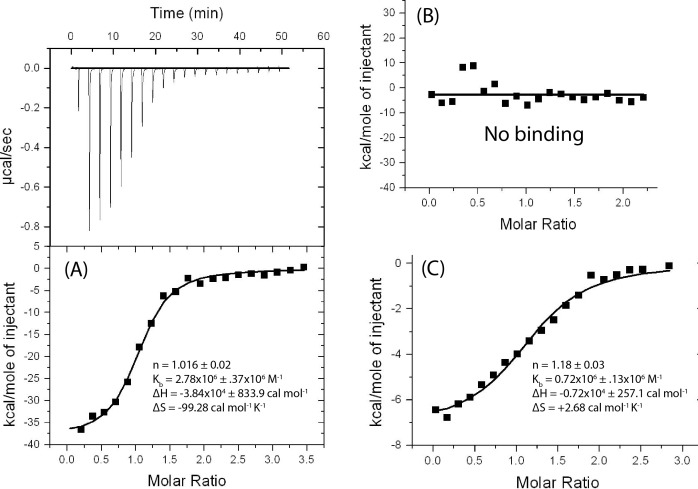
Isothermal Titration Calorimetry (ITC) of tRNA binding to T-box182.T-box182 contains extensions at both 5’ and 3’ ends with (A) unlabeled tRNAGly in 10 mM MgCl2 buffer, (B) unlabeled tRNAGly in 1 mM MgCl2 buffer and (C) 5’-Cy5 labelled tRNAGly in 10 mM MgCl2 buffer. (A) is a representative ITC profile in which the upper panel shows the heat change due to successive injections of tRNAGly to a T-box182 construct with extensions at both the 5’ and 3’ ends (Supplementary file 1) and the lower panel shows the binding isotherm obtained by integrating the heat change associated with each injection and plotting it as a function of molar ratio of tRNAGly to T-box182. (B) and (C) depict only the integrated binding isotherm. The first injection of the titration in all three ITC experiments was performed by injecting 0.5 µL of tRNAGly to minimize contribution of any artifact associate with loading the syringe. A curve was fitted to the integrated data using a single-site model with Origin 5.0 (OriginLab). Thermodynamic parameters are derived from a best fit curve ±minimized fitting error by non-linear regression analysis. (A) shows that unlabeled tRNAGly in 10 mM MgCl2 buffer binds with an affinity (1/Kb) of 360 nM which is comparable to the one reported for a similar construct (209 nM) (Zhang and Ferré-D'Amaré, 2013), but without the extensions. The experiment therefore shows that the extensions have a negligible effect on tRNA binding. (B) shows that in 1mMgCl2 buffer, tRNAGly does not bind to the T-box, suggesting that the T-box-tRNA interaction is strongly dependent on Mg2+ concentration. (C) shows that the addition of Cy5 fluorophore to the 5’ end of tRNAGly is only slightly detrimental for optimal binding to the T-box with ~4 fold reduction in affinity.